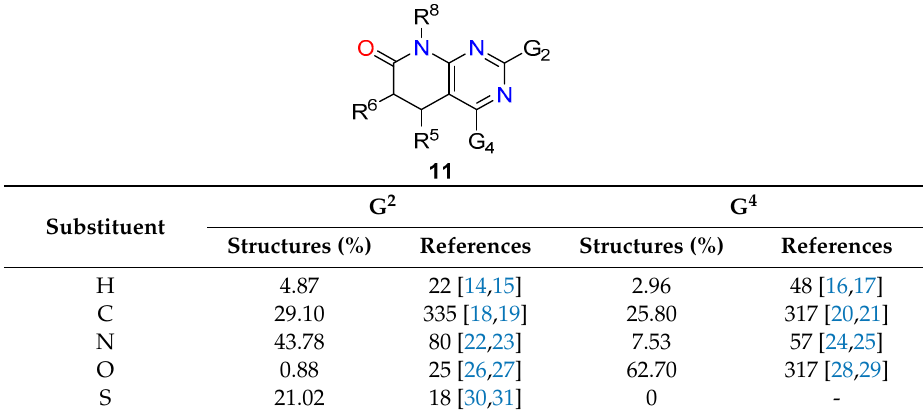
Table 1. Substitution pattern at C2 and C4 of 5,6-dihydropyrido[2,3- d ]pyrimidin-7(8 H )-ones ( 11 ) with a C5-C6 single bond.